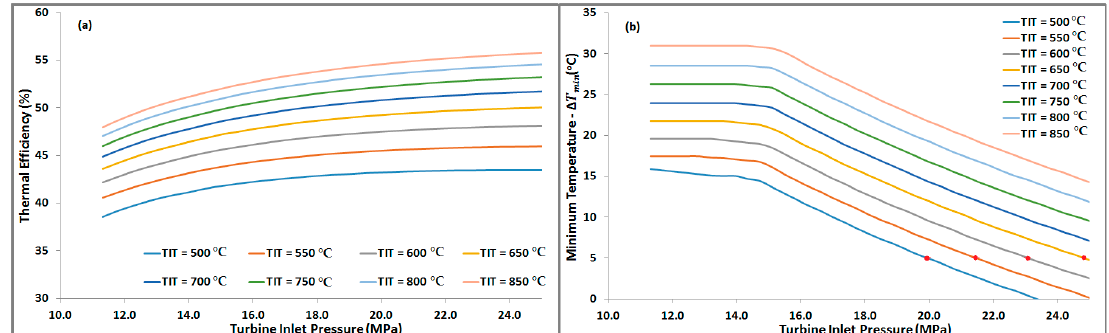
Figure 4. ( a ) Thermal efficiencies of RBC-PC plotted versus turbine inlet pressure for TIT from 500 °C to 850 °C. ( b ) Minimum pinch temperature versus turbine inlet pressure; red dots represent the minimum pinch temperature of 5 °C. Table 1. Turbine inlet pressures at different turbine inlet temperatures for maximum thermal efficiency of the recompression Brayton cycle with partial cooling (RBC-PC).